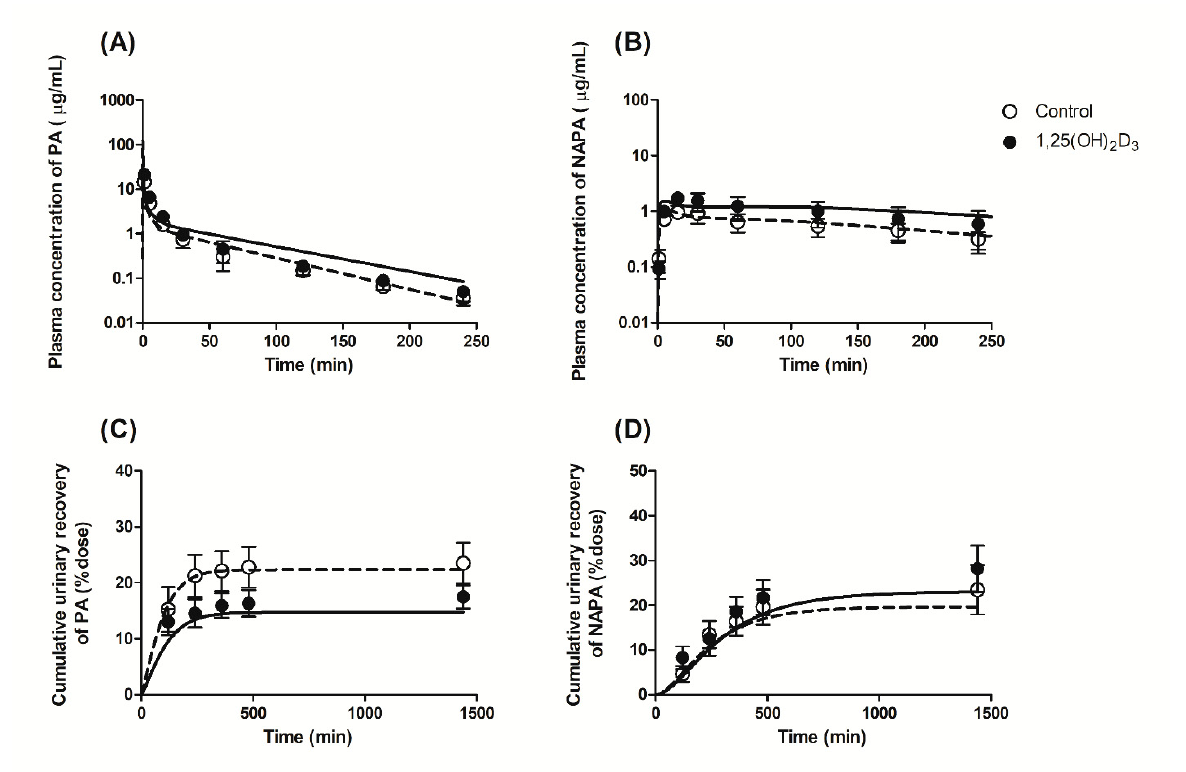
Figure 6. Observed and simulated plasma concentration-time profiles ( A , B ) and cumulative urinary excretion profiles (% of dose) ( C , D ) for PA ( A , C ) and NAPA ( B , D ) after intravenous administration of 10 mg/kg PA HCl in the absence or presence of 1,25(OH) 2 D 3 treatment. Open circles and dashed lines represent the observed and simulated results for the control group, whereas closed circles and solid lines denote the observed and simulated results with the treatment group, respectively. Symbols represent the mean ± S.D.